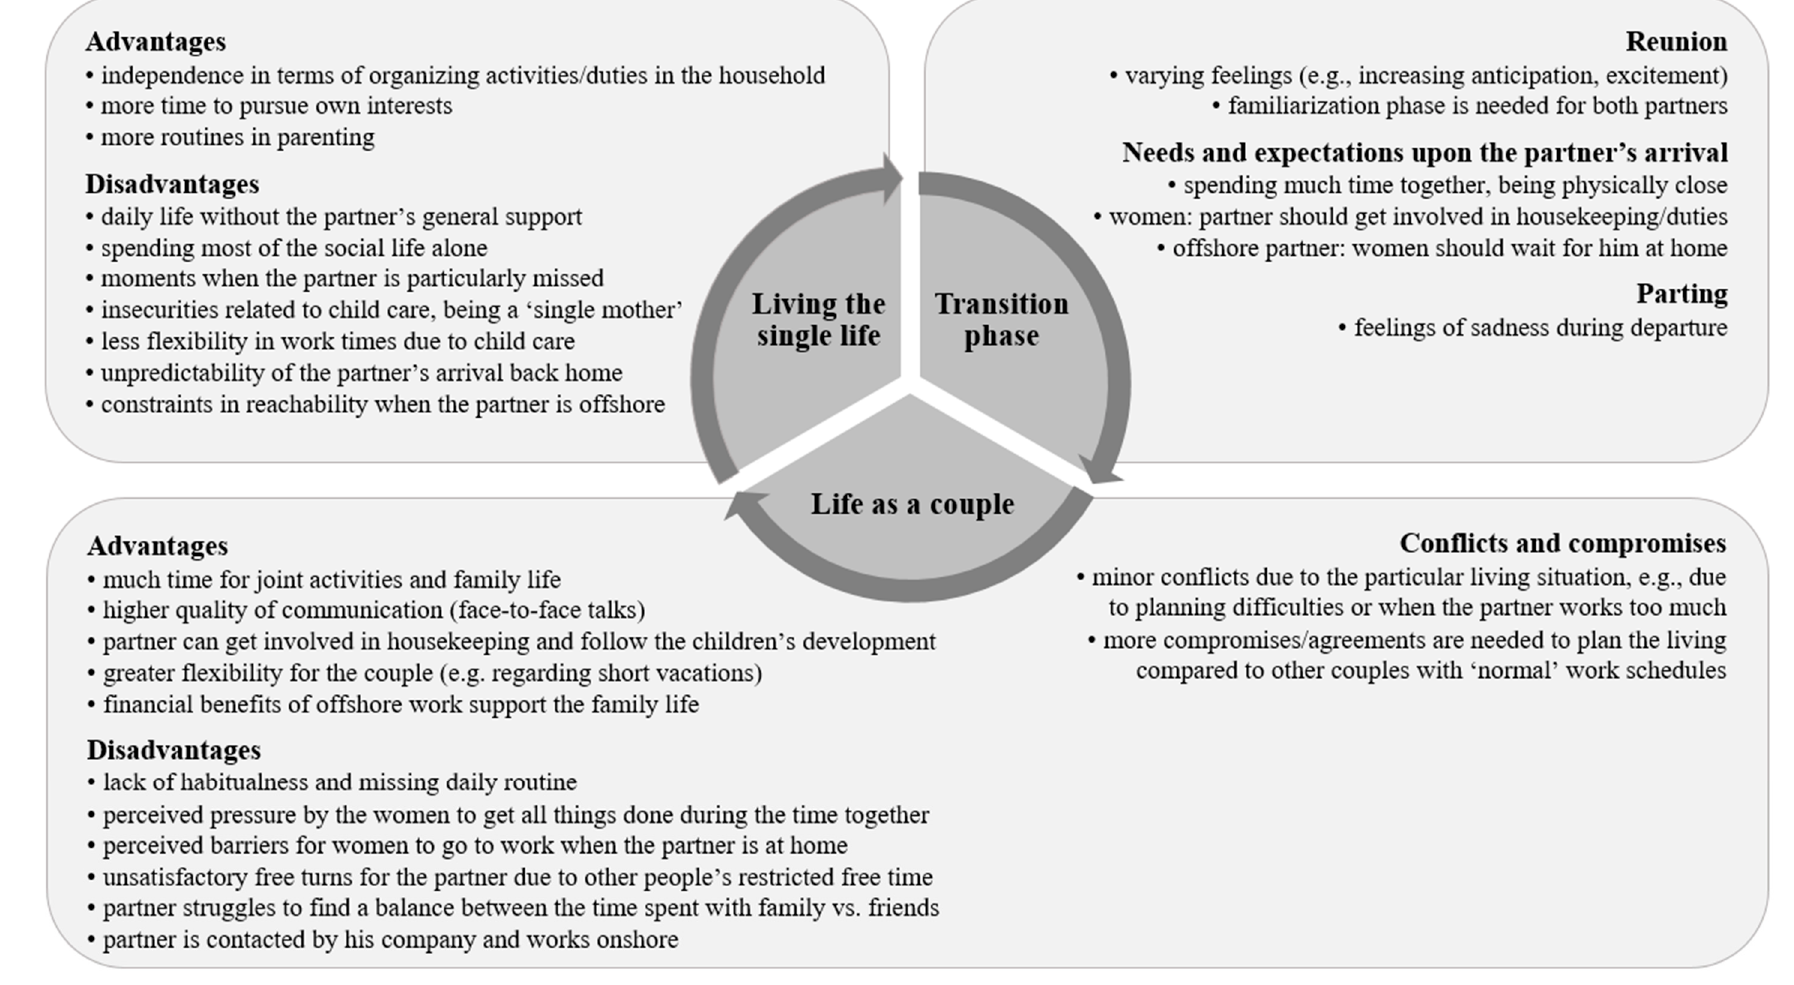
Figure 1. Specific features of living the 14/14 schedule related to the phases of daily life.